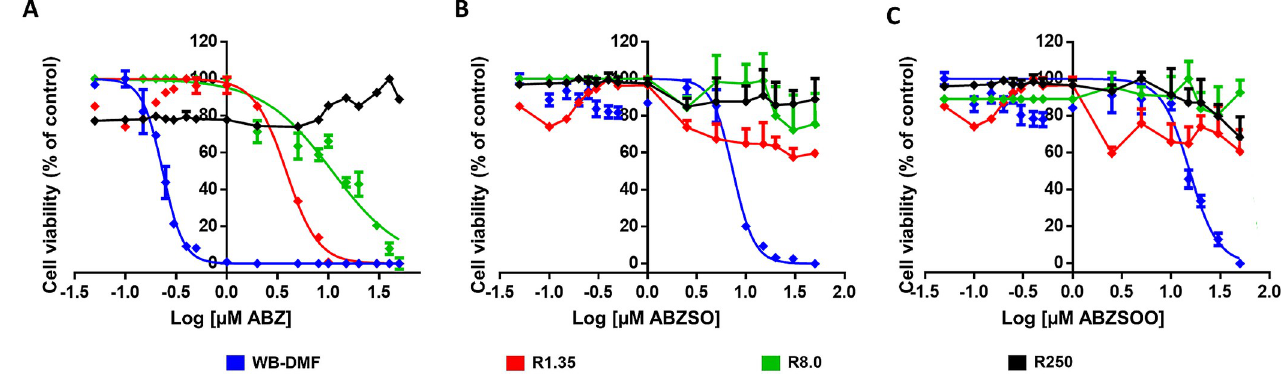
Fig 2. Concentration-viability curves of ABZ-sensitive and ABZ-resistant G . duodenalis trophozoites to ABZ and its metabolites. Cell viability of trophozoites exposed to increasing ABZ (A), ABZSO (B) and ABZSOO (C) concentrations (shown in logarithmic scale) for 24 h was determined by Trypan blue exclusion. The IC 50 values correspond to n = 3 independent experiments, respectively. Standard deviations are shown for each drug concentration and for each IC 50